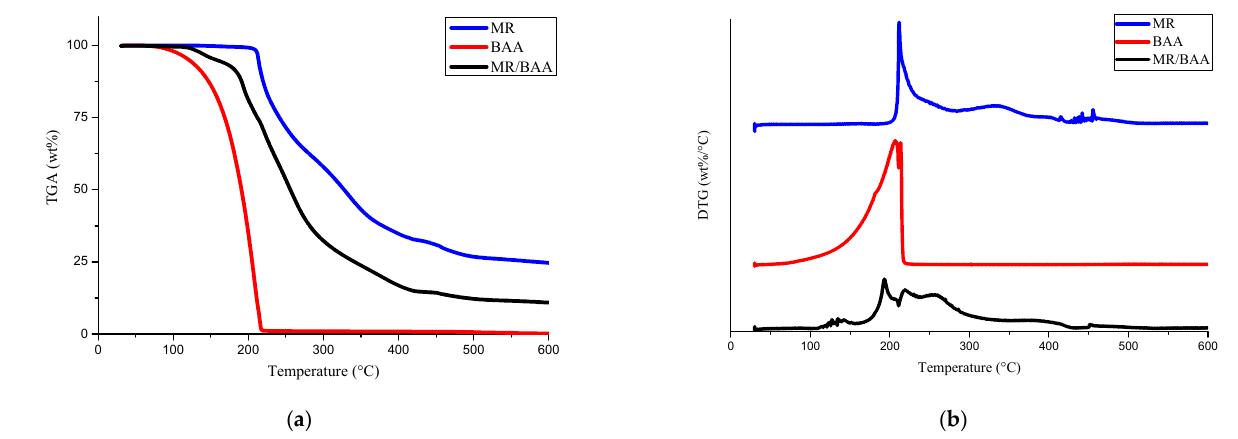
Figure 4. ( a ) Thermogravimetric analysis (TGA) curves for MR, BAA, and MR–BAA compounds, and ( b ) the first derivative of the TGA curves (i.e., DTA curves).